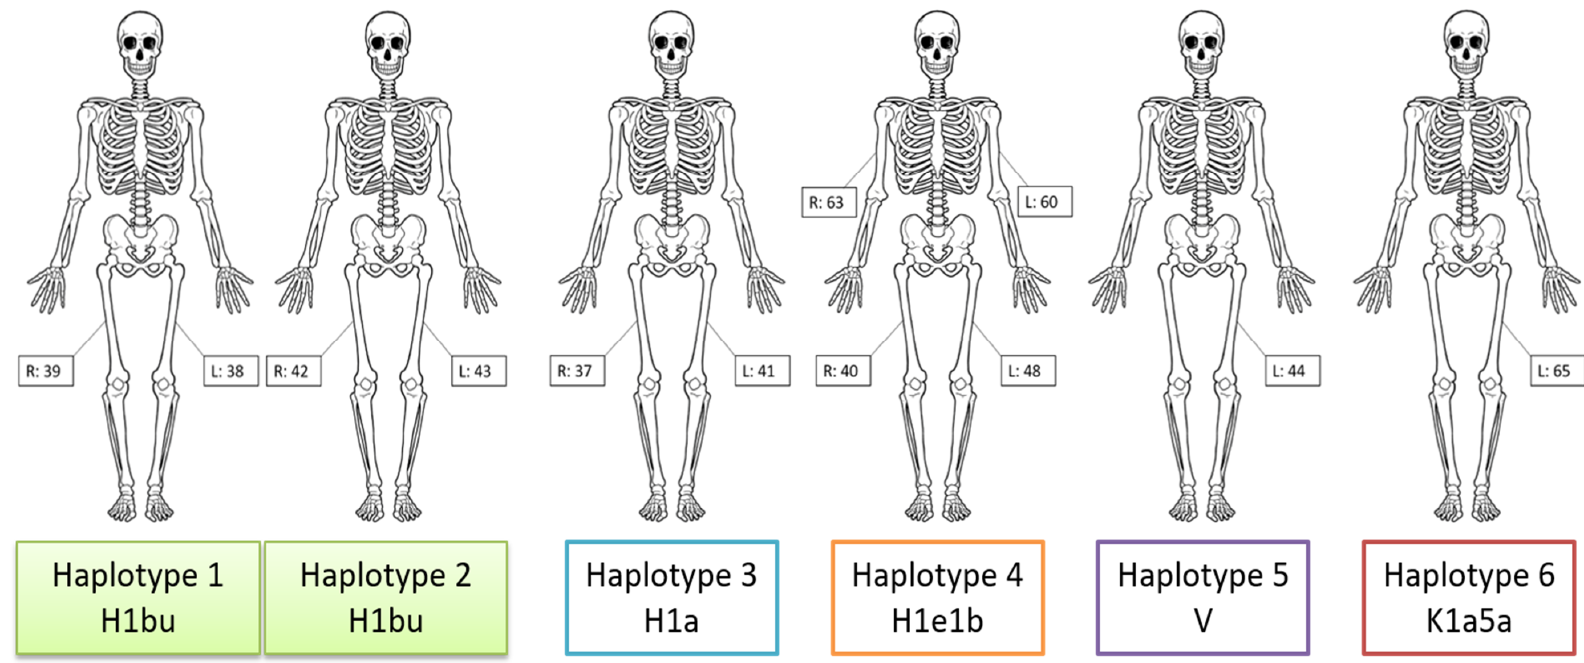
Figure 3. Reassociated skeletal elements based on mitogenome haplotype. Six unique haplotypes were identified, which allowed the skeletal remains to be grouped into a minimum of six individuals. Mitochondrial haplogroups are indicated. R = right and L = left skeletal element.